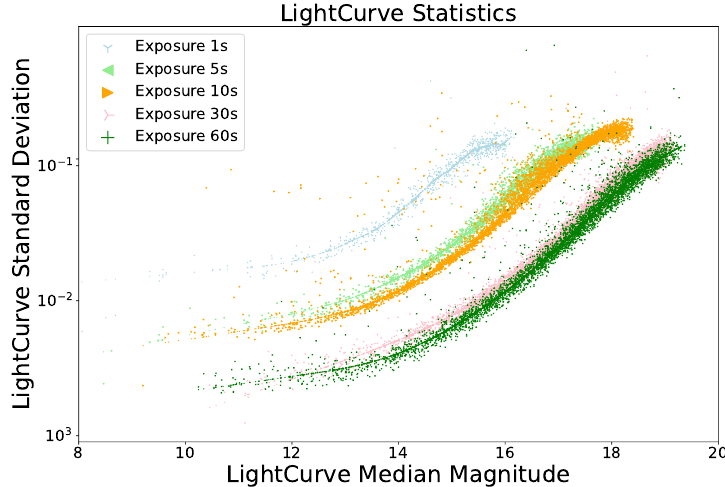
Figure 9. The trends of different colour points show the magnitude statistics in light curves for stars in different exposure times from one second to 60 s. In the centre of each exposure-time group, we use the local regression method to show the major trends.